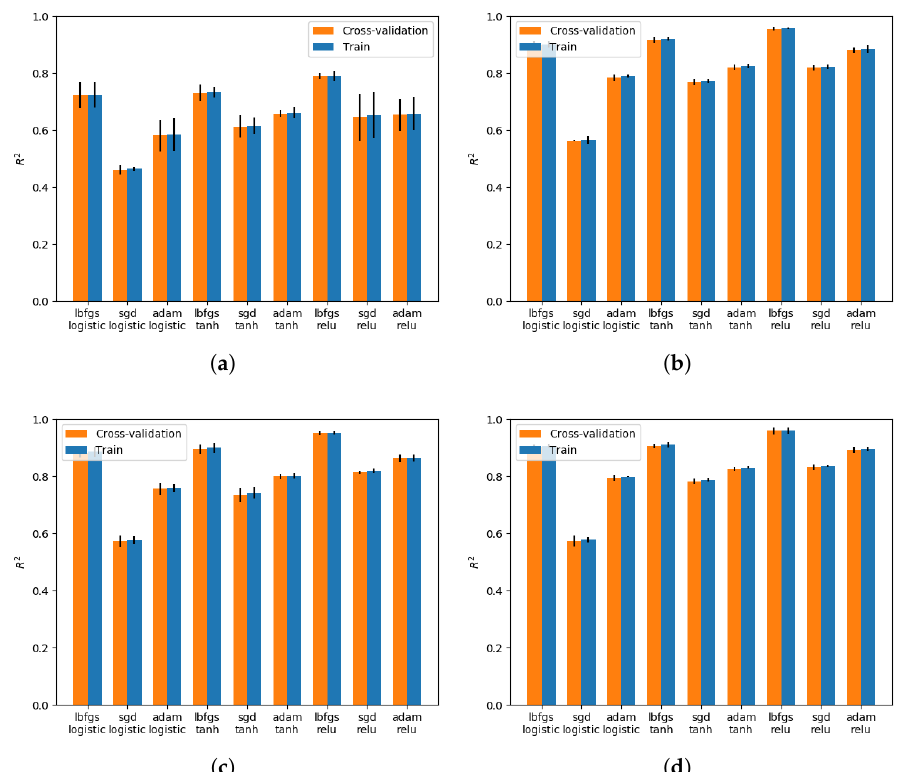
Figure 15. Combination of different optimization algorithms, activation functions and ANN hidden layer size used in a grid search approach. Topologies of ( a ) 4, ( b ) 10, ( c ) 16 and ( d ) 22 hidden neurons [22].